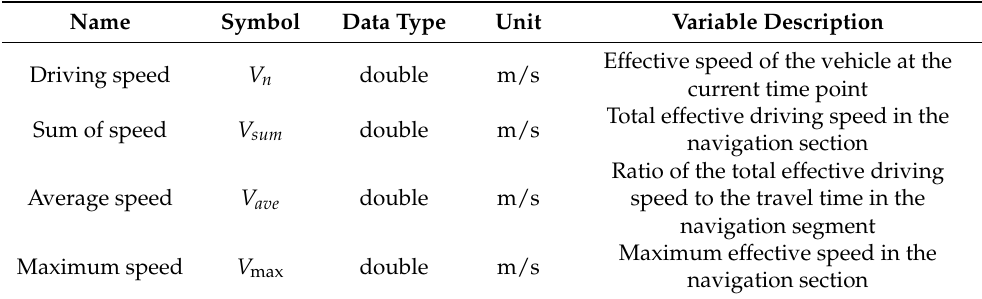
Table 2. Intermediate variables of average and maximum velocity acquisition algorithm.